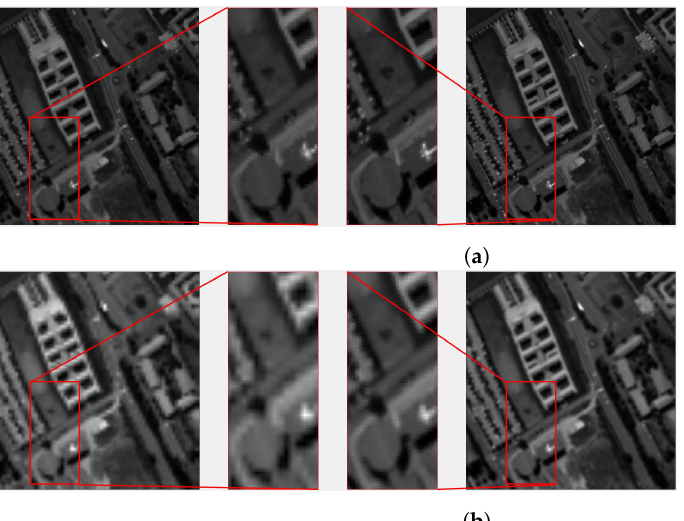
Figure 9. Visual quality inspection for Sequence 1 , ( a ) EF = 2 (N = 8) and ( b ) EF = 4 (N = 24) at 630 nm band. On the left, the interpolated image and with a zoom over the area of interest; on the right, the super-resolved image with its zoom.